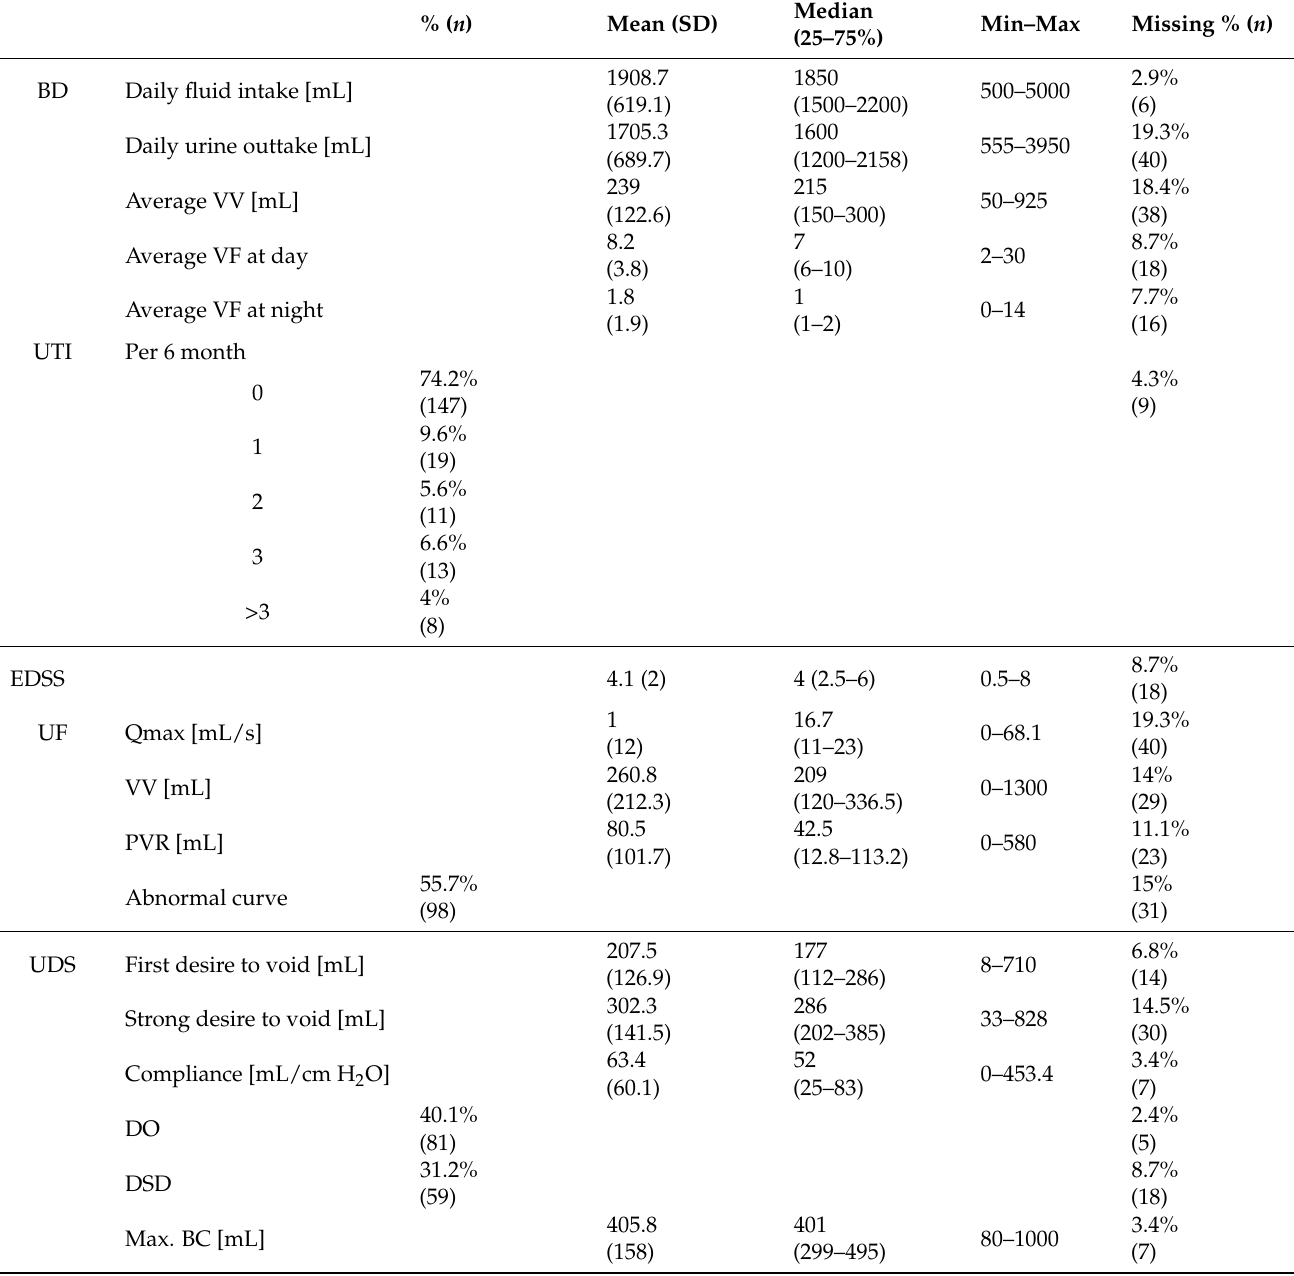
Table 2. Summary of the parameters of BD, uroflowmetry, UDS, and